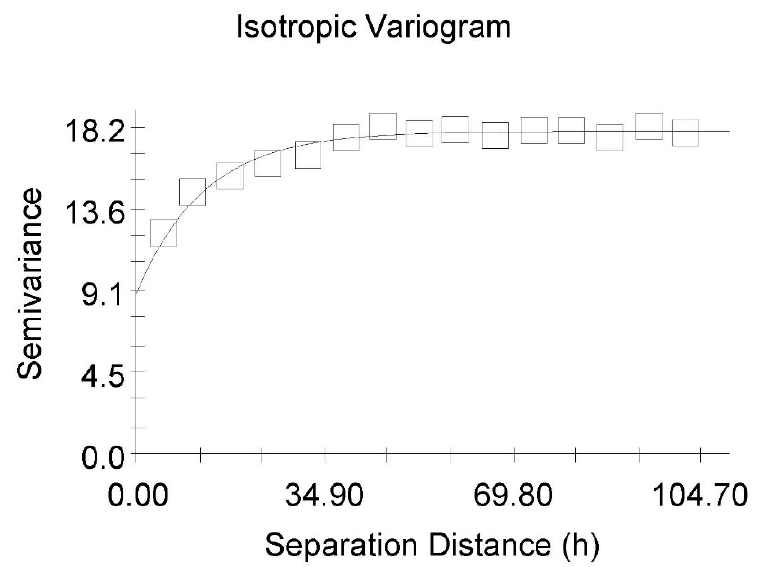
Figure 5. Semivariogram of VMC in the harvest stage with an exponential model.